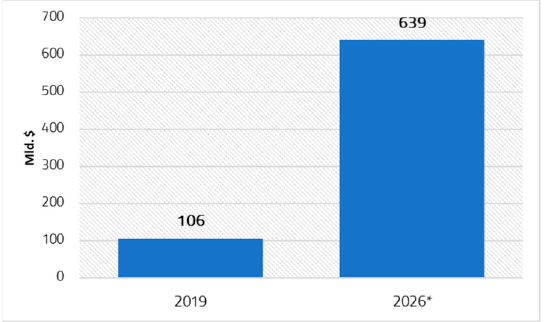
Figure 1. Global digital health services market in 2019 and forecast to 2026. Note: * forecasting.